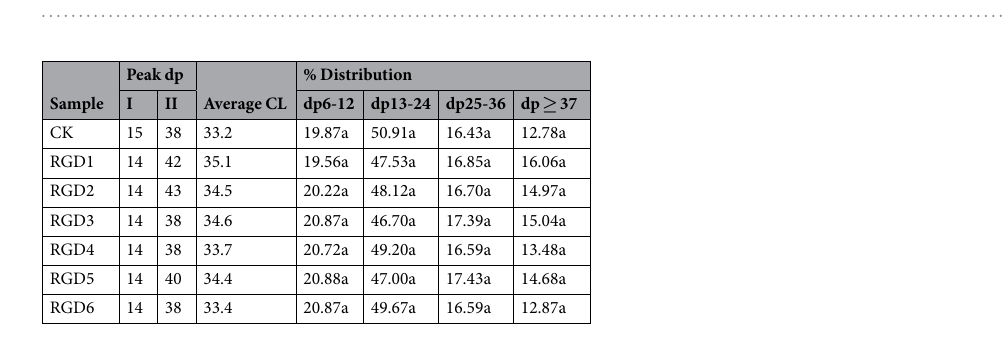
Table 4. Chain-length distributions of amylopectin. Different letter indicates significant difference ( P <